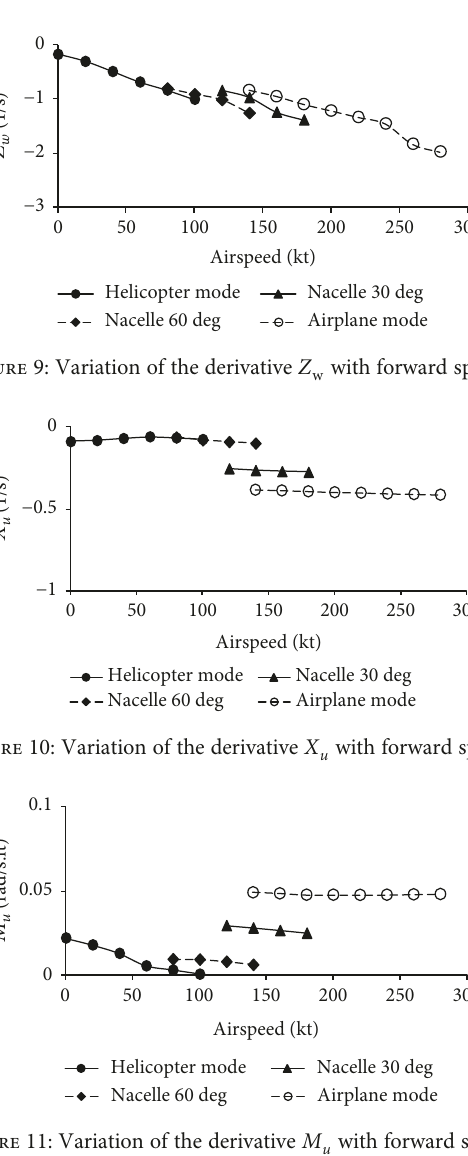
with forward speed. u